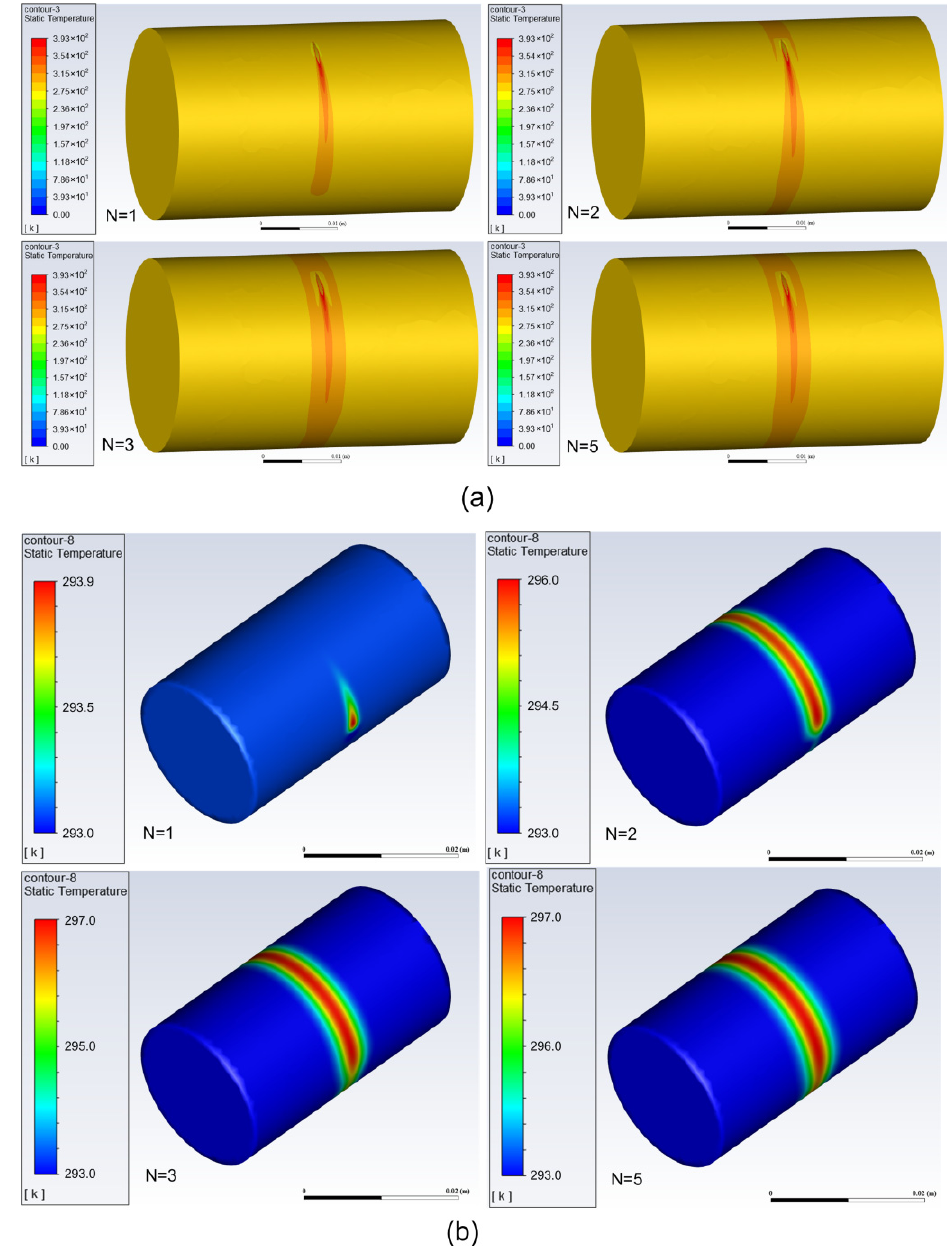
Figure 8. The contour of temperature distribution with different turns: ( a ) distribution on outer wall; ( b ) distribution on inner wall.